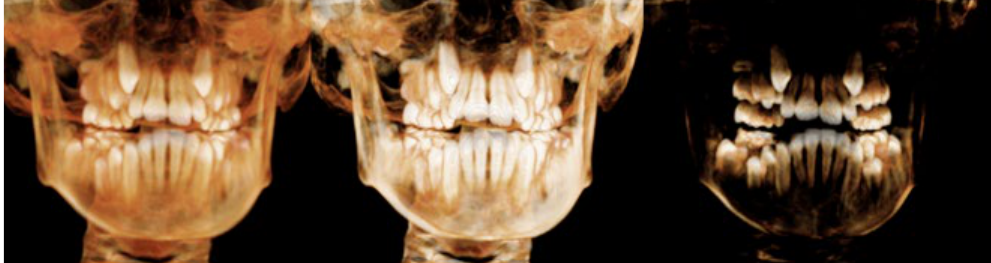
Figure 1. Protocol for isolation of the unerupted teeth. Choosing ‘Dental view’, boosting the contrast and finally bringing down the brightness.